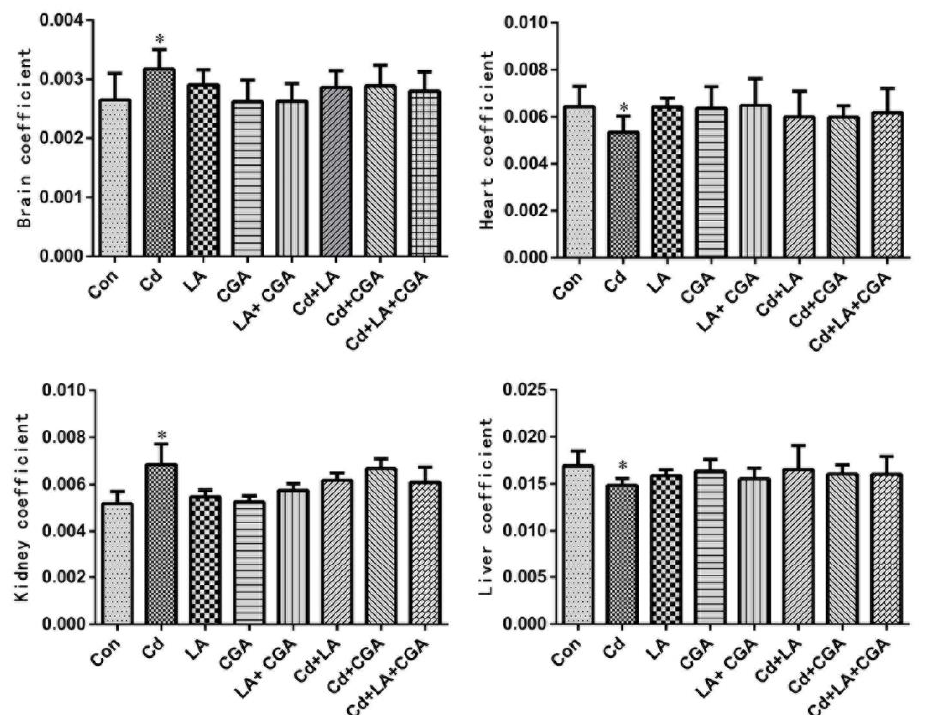
Figure 1. Effects of α - lipoic acid and chlorogenic acid on the coefficients of four different organs of cadmium poisoned chickens ( n = 3, x ± s). Electronic balance was used to weigh heart, liver, kidney and brain. Organ coefficient % = (organ mass/body mass) × 100%. * p < 0.05 vs. control.